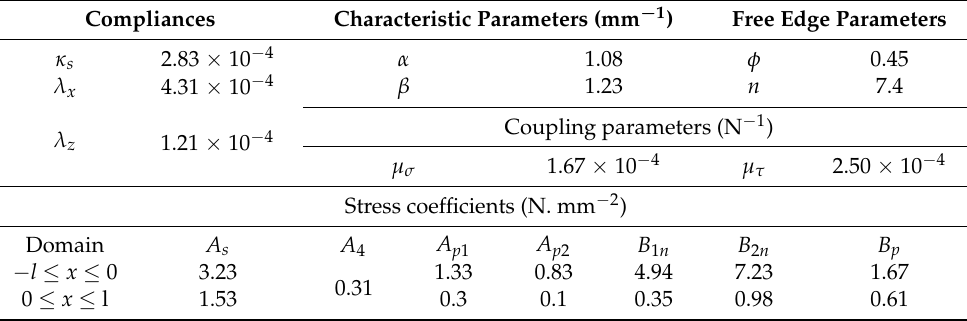
Table 1. Numerical validation: characteristics of the unbalanced